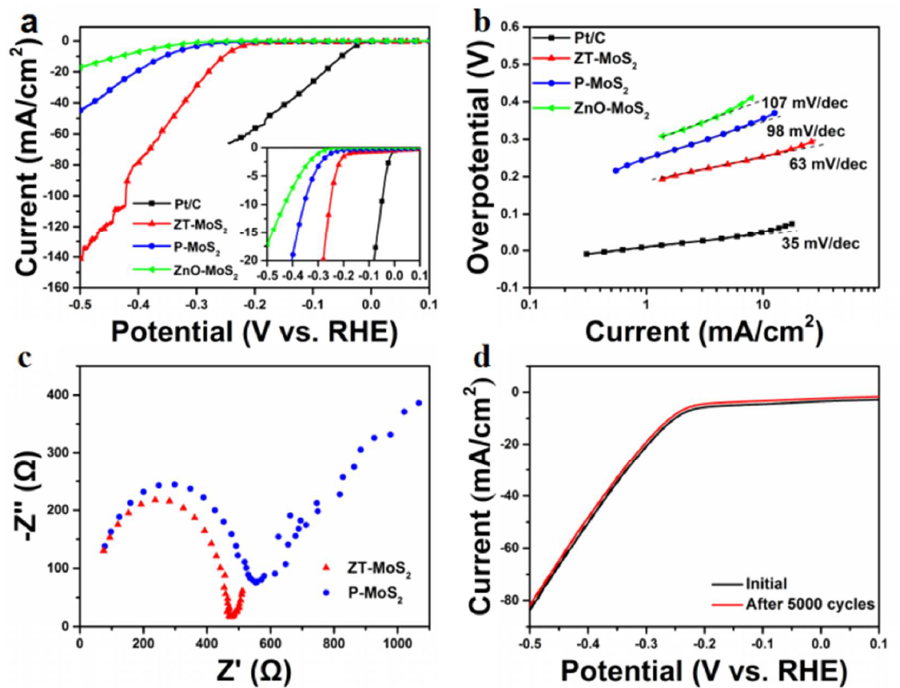
Figure 4. Electrochemical characterizations of as-product catalysts. ( a ) Polarization curves of Pt/C, ZT-MoS 2 , P- MoS 2 , ZnO-MoS 2 . ( b ) Tafel plots of Pt/C, ZT-MoS 2 , P-MoS 2 , ZnO-MoS 2 . ( c ) Electrochemical impedance spectroscopy (EIS) Nyquist plots of ZT-MoS 2 and P-MoS 2 . ( d ) Durability test of ZT-MoS 2 through 5000 cycles linear sweep voltammetry (LSV).